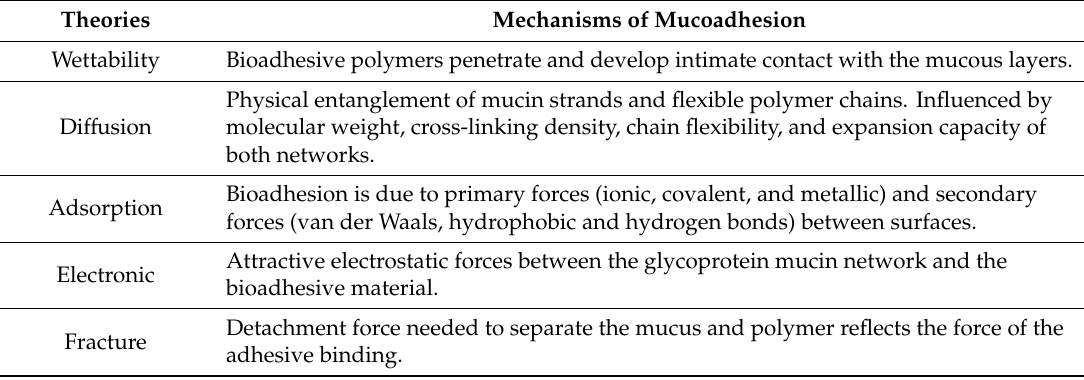
Figure4. MucoadhesiveGRDDS( a )generalrepresentationofmucoadhesivesystemsand( b )mechanism Figure 4. Mucoadhesive GRDDS ( a ) general representation of mucoadhesive systems and ( b ) of mucoadhesive systems. mechanism of mucoadhesive systems. Table 5. Suggested mechanisms of mucoadhesion Table 5. Suggested mechanisms of mucoadhesion [1,81] .